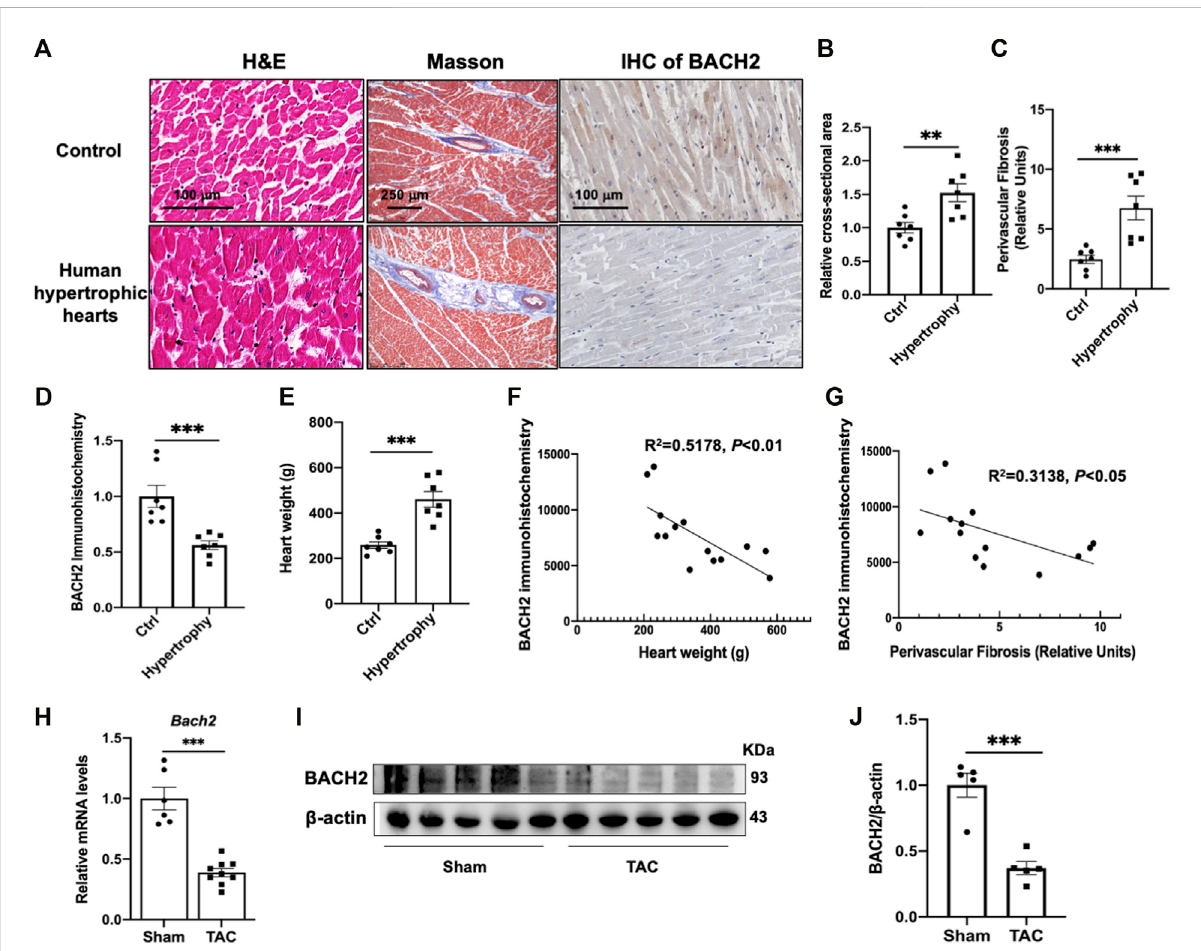
Expression of BACH2 in hypertrophic mouse hearts and histological analyses of human hypertrophic hearts. (A) H & E, Masson and immunohistochemistry (IHC) stain of human hypertrophic and control hearts (n=7). (B – D) Quantitative analyses of myocardial cross-sectional area, perivascular fi brosis (relative to vascular area) and BACH2 immunohistochemistry. Eight fi elds from each sample were randomly selected for analyses. (E) The heart weight difference. (F – G) The correlation of BACH2 immunohistochemistry quantitative value with heart weight and extent of perivascular fi brosis. (H) RT-qPCR analyses showing Bach2 mRNA levels in mouse hearts at 5 weeks after sham or transverse aortic constriction (TAC) surgery (n=6- 9). (I – J) Western blot and quanti fi cation analyses of BACH2 protein levels. * P < 0.05, ** P < 0.01, *** P <